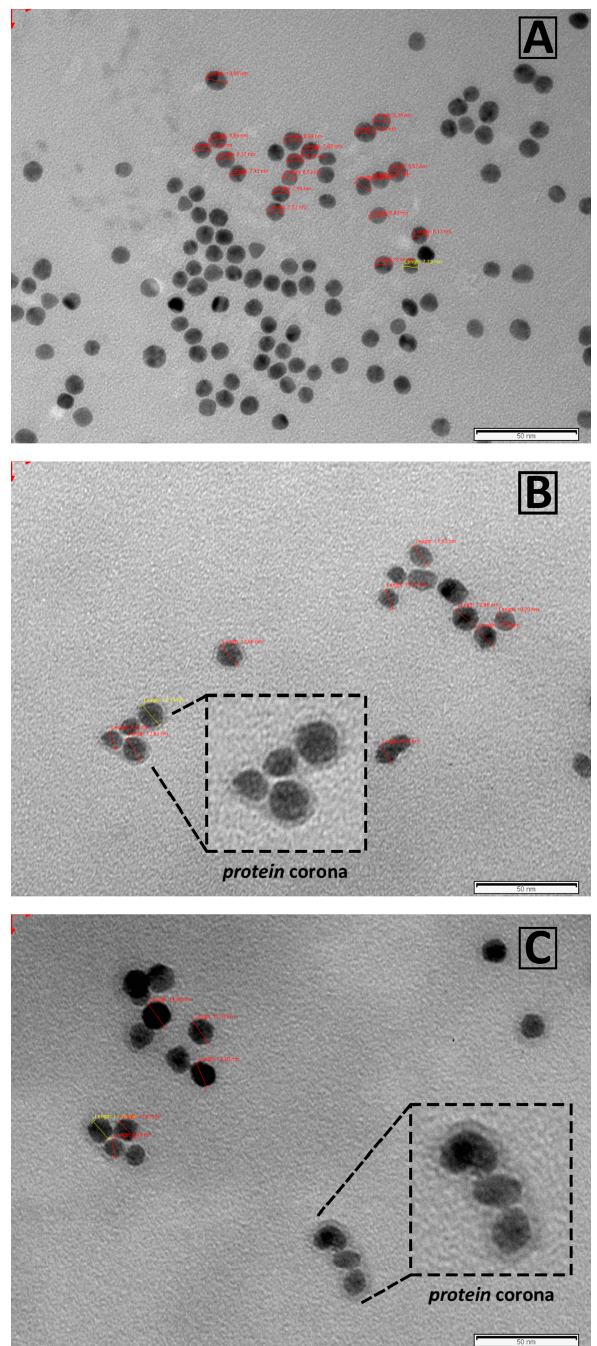
Figure 3. Negative stain TEM imaging of bare ( A ) and protein corona-coated AuNPs, recovered post-incubation with human serum obtained from HC ( B ) and BC patients ( C ). All scale bars are 50